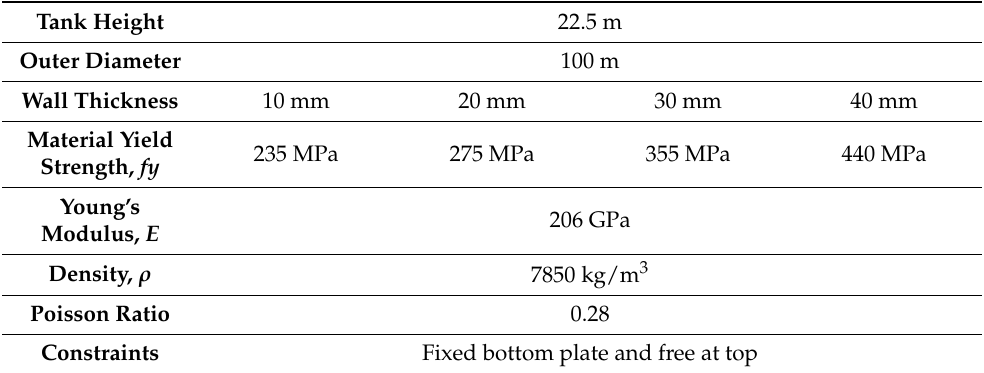
Table 1. Design parameters for the thin-walled cylindrical storage tank.